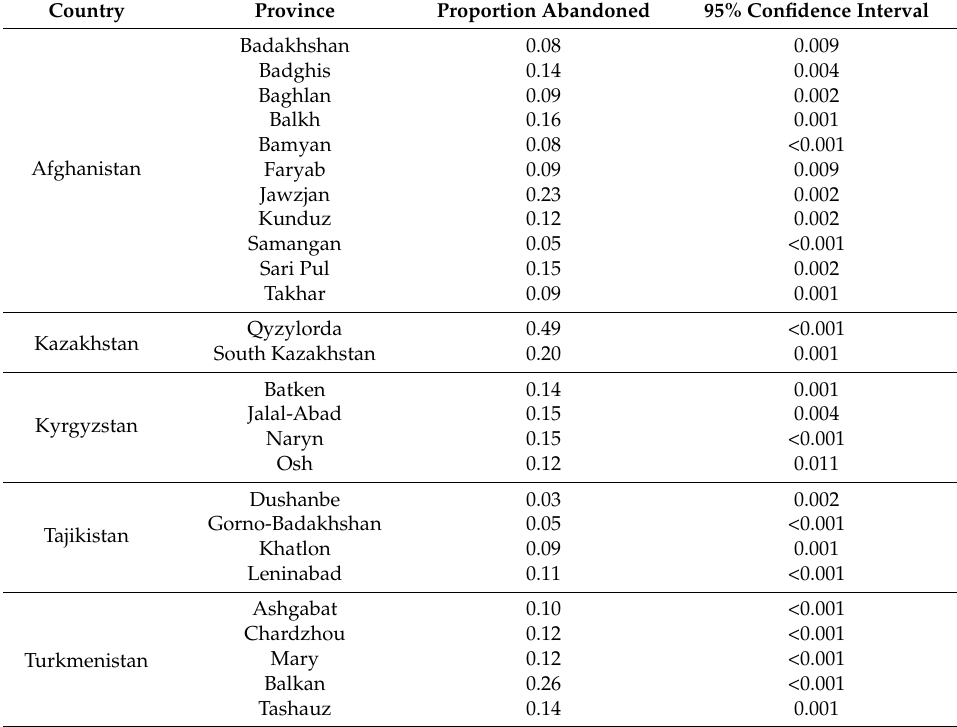
Figure 7. Map of abandoned irrigated cropland (for 2016) in six countries of the Aral Sea Basin as derived by the stratified classifier method. Table 5. Estimates of the proportion of abandoned irrigated cropland to the total cropland in 39 administrative level-II regions (provinces) in six countries of the Aral Sea Basin and error-adjusted area estimates with 95% confidence intervals.